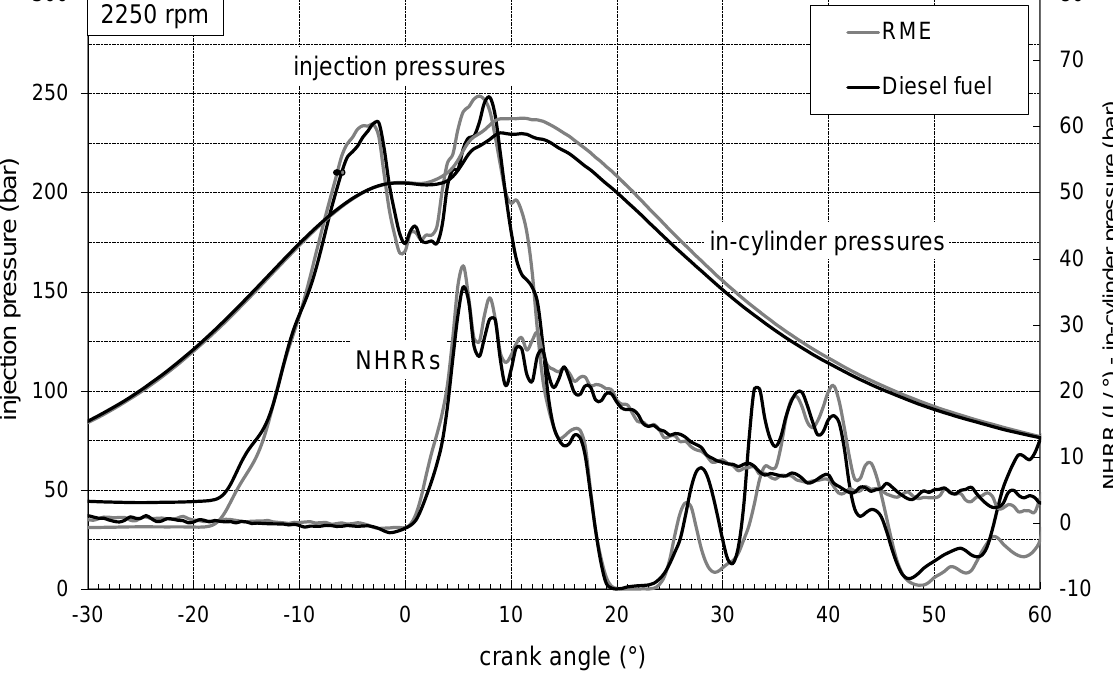
Figure 9. RME and diesel fuel injection pressures, in-cylinder pressures, and NHRR at 2500 rpm and at full load.